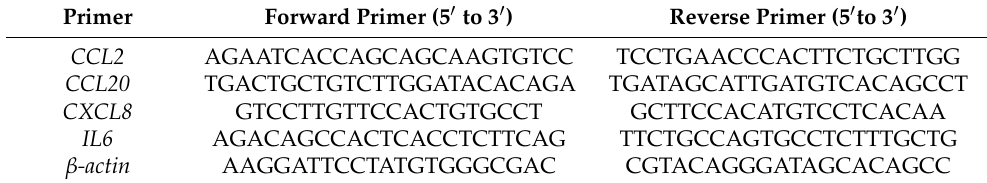
Table 3. The sequences of the